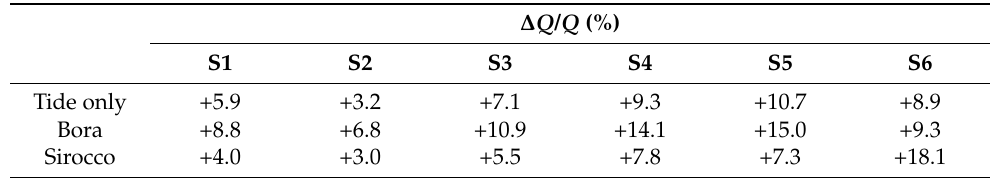
Figure 16. Simulations with a dredged Taglio channel. Water flow through selected cross sections: ( a ) Hydrographs resulting from the tidal simulation with no wind forcing; ( b ) Hydrographs resulting from the Bora simulation; ( c ) Hydrographs resulting from the Sirocco simulation. Table 4. Simulations with a dredged Taglio channel. Flow variations with regard to the corresponding simulation on the reference configuration.